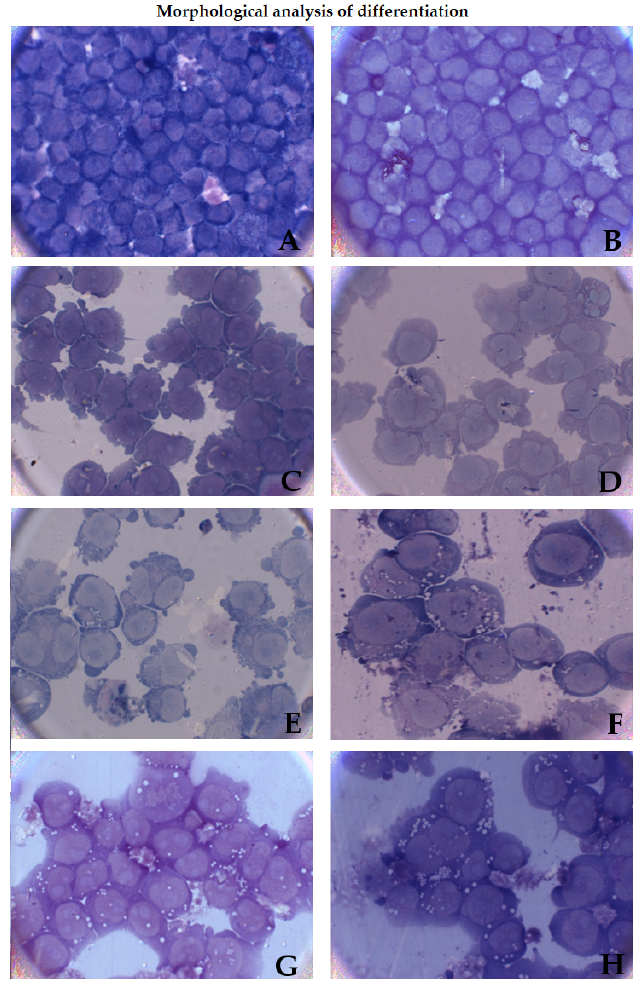
Figure 4. ( A – H ) Leishman’s stained HL-60 cells exposed to RPMI—Medium only negative control ( A ), Vehicle control 0.5% Ethanol ( B ), 1.6% DMSO on day 3 ( C ), 1.6% DMSO on day 5 ( D ), 10 nM PMA on day 3 ( E ), 10 nM PMA on day 5 ( F ), 9.23 ppm tyrosol on day 3 ( G ), 9.23 ppm tyrosol on day 5 ( H ). Magnification 1000×.